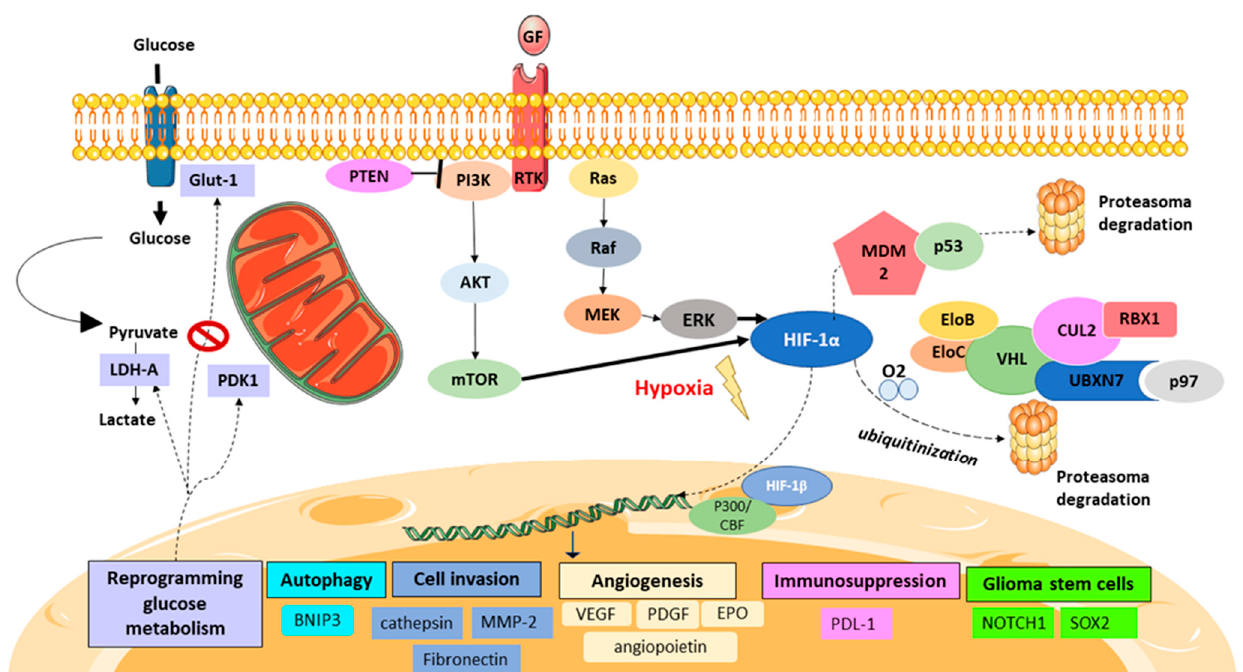
Figure 1. HIF-1 signaling pathway in GB. The presence of oxygen (O 2 ) leads HIF-1 α ubiquitination and its proteasome degradation via the VHL complex. Hypoxia stabilizes HIF-1 α after it translocates to the nucleus, heterodimerizing with HIF-1 β , after its binding to DNA, helped by the coactivators P300/CBF to perform its action as a transcription factor. The PI3K/PTEN and MAPK/ERK pathways con also activate HIF-1 due to activator mutations and due to the activation of receptor tyrosine kinase (RTK) or the presence of growth factor (GF). HIF-1 activation promotes the transcription of several genes activating angiogenesis, metabolic reprogramming, cell invasion, immunosuppression, and cancer stem cell phenotypes.